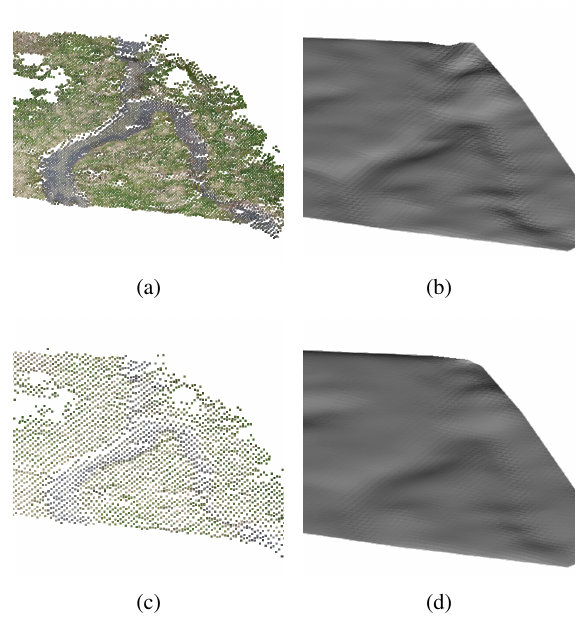
Figure 7. The photogrammetric point cloud with lower resolution(a: 40cm, c: 80 cm) and the corresponding DEMs (b,d) Figure 6. Corresponding 2.5D DEM to the shown point cloud data (see figure 5) a) DEM for the ALS data, b) DEM for the photogrammetric point cloud.